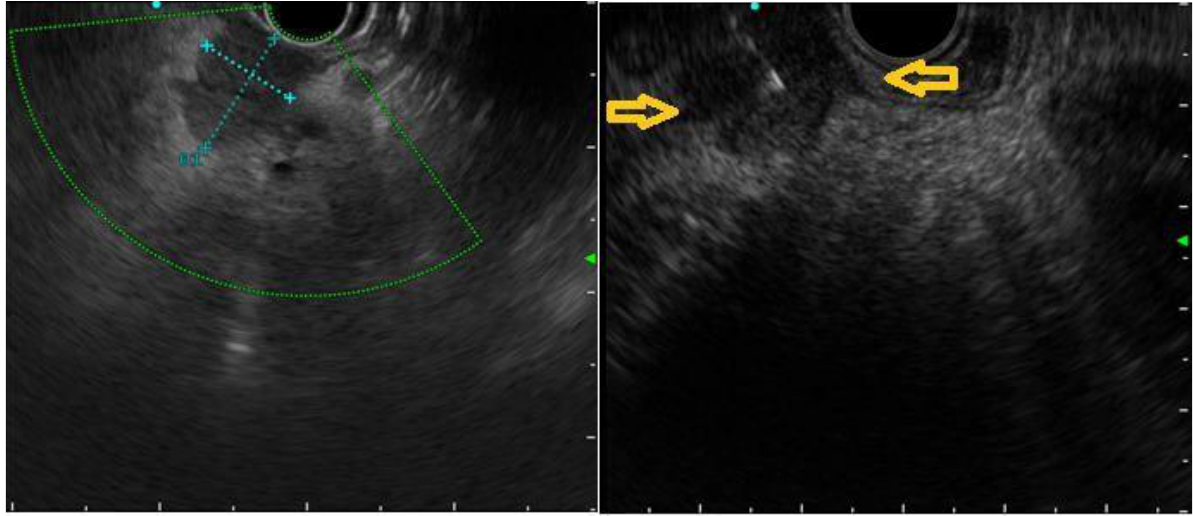
Figure 2. Breast cancer metastasis to pancreas. Yellow arrows point at margins’ irregularity.